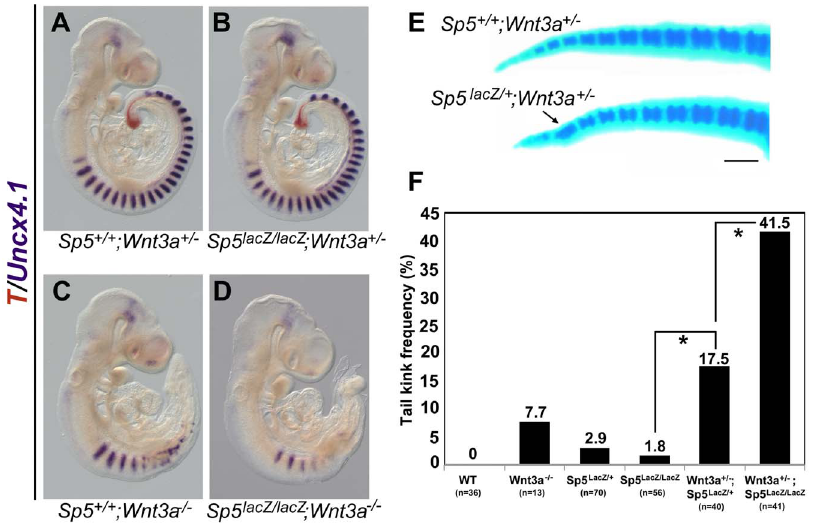
Figure 4. Genetic interactions between Sp5 and Wnt3a during tail development. (A–D) Two-color WISH illustrating Uncx4.1 (purple) and T (orange) in Sp5 + / + ; Wnt3a + / 2 (A), Sp5 lacz/lacz ; Wnt3a + / 2 (B), Sp5 + / + ; Wnt3a 2 / 2 (C), and Sp5 lacz/lacz ; Wnt3a 2 / 2 double mutants (D) at E9.5. Double mutants ( n =8) display fewer and less-defined Uncx4.1 + anterior somites as compared to stage-matched Wnt3a null embryos. (E) At E18.5, Sp5 lacz/ + ; Wnt3a + / 2 animals (bottom) display abnormal, fused tail vertebrae (arrow) compared to Sp5 lacz/ + ; Wnt3a + / 2 mice (top). (F) Frequency of tail kinks (expressed as %) observed in Wnt3a + / 2 heterozygotes at 6 weeks of age increased dramatically as the Sp5 gene dosage was reduced. The number of animals examined (n) is indicated below each genotype. *, statistical significance (p , 0.0001, Chi-squared t-test). Scale bar=500 um